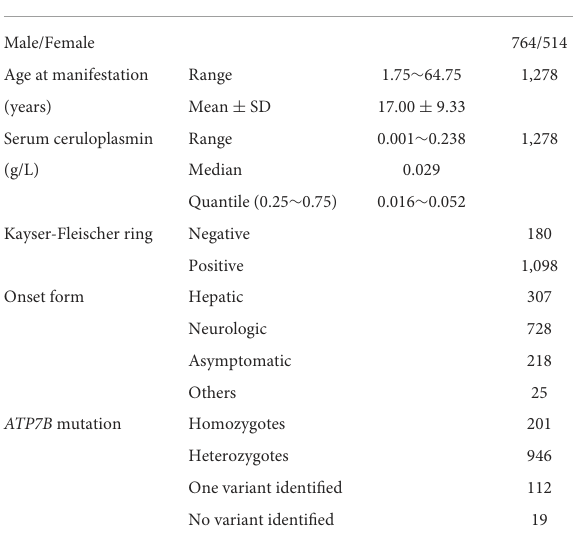
TABLE 1 Demographic characteristics of patients with